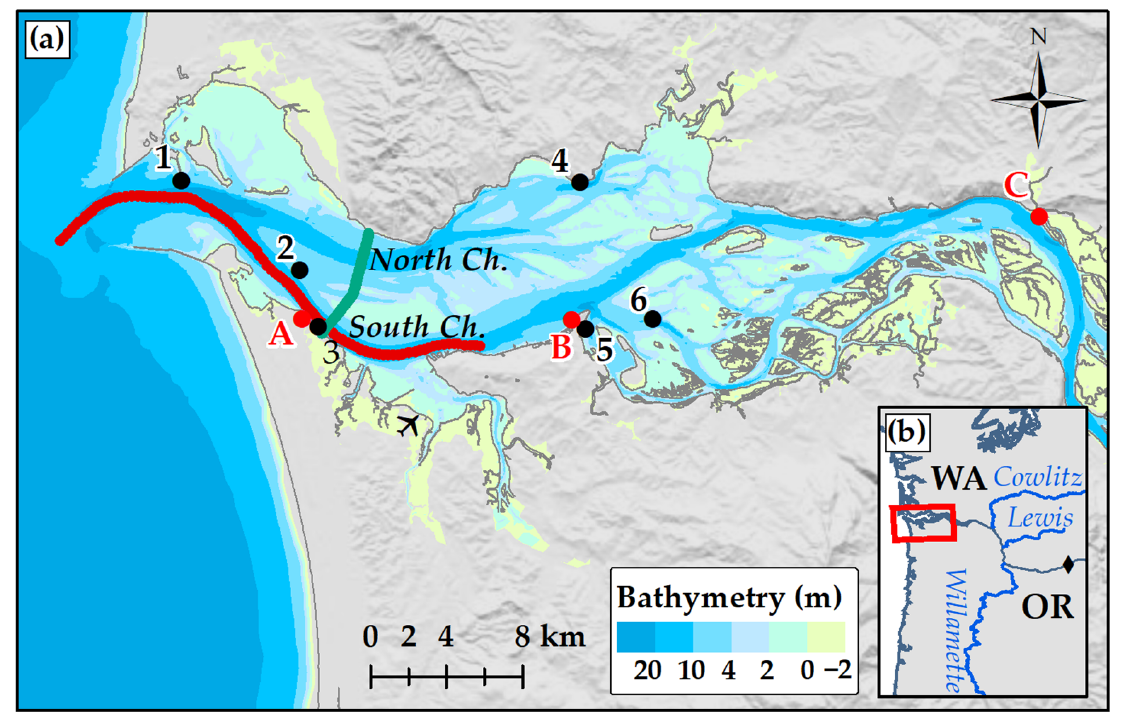
Figure 1. Map with ( a ) bathymetry and ( b ) location of the Columbia River estuary between Oregon (OR) and Washington States (WA). The black dots in ( a ) indicate the locations of the observational stations used in the study. 1: Jetta; 2: Desdemona sands (DSDMA); 3: SATURN − 03, 4: Grays; 5: SATURN − 04; 6: CBCN3. The red dots represent the tide gauges. A: Hammond; B: Astoria/Tongue Point (TPOIN); C: Skamokawa. The airplane symbol indicates Astoria airport. The red line represents the along-channel transect of the South channel, while the green line represents the cross-channel transect, starting from SATURN − 03 station, referred to as transect of Point Adams. Offshore NOAA station 46,029 is about 40 km west from the mouth. The black diamond in ( b ) indicates Bonneville Dam, the upstream limit of the domain, while Cowlitz, Lewis, and Willamette indicate the minor river inputs (in blue).